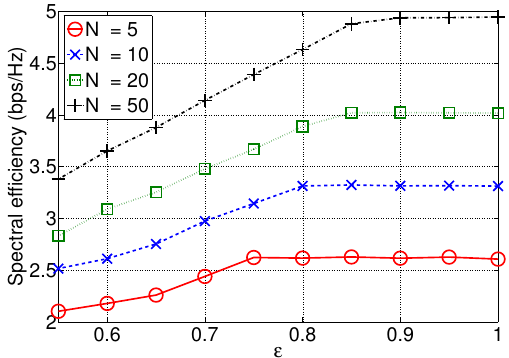
Figure 5. Spectral efficiency vs. (cid:101) by varying N .